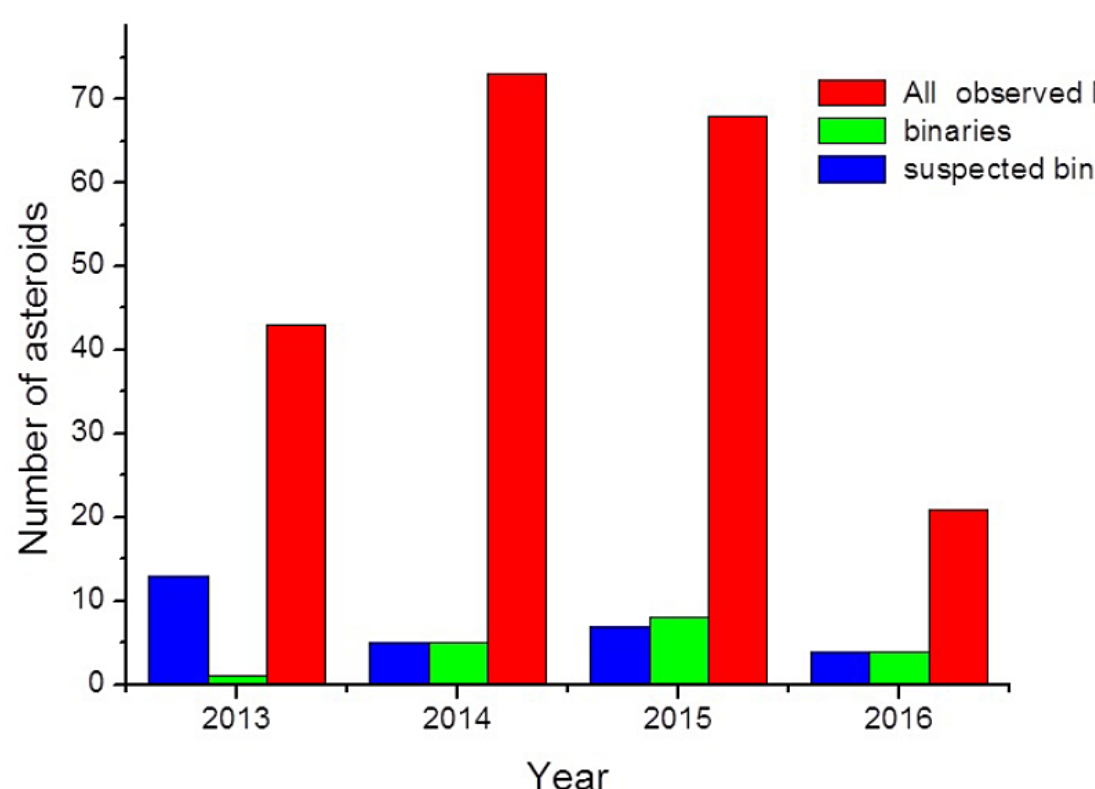
Figure 9. Number of simple, binary and potentially binary NEAs observed in 2013-2016. Statistics of observations over a 4-year period. Vertical axis –numbers of asteroids, horizontal –